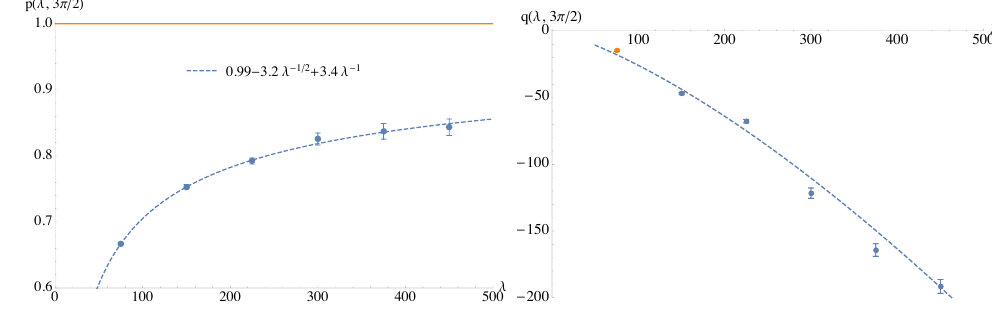
Figure 4 . Functions p ( λ, π ) (left) and q ( λ, π 2 λ = 2 λ 1 λ 2 = 3 λ 1 . λ 1 + λ 2 2